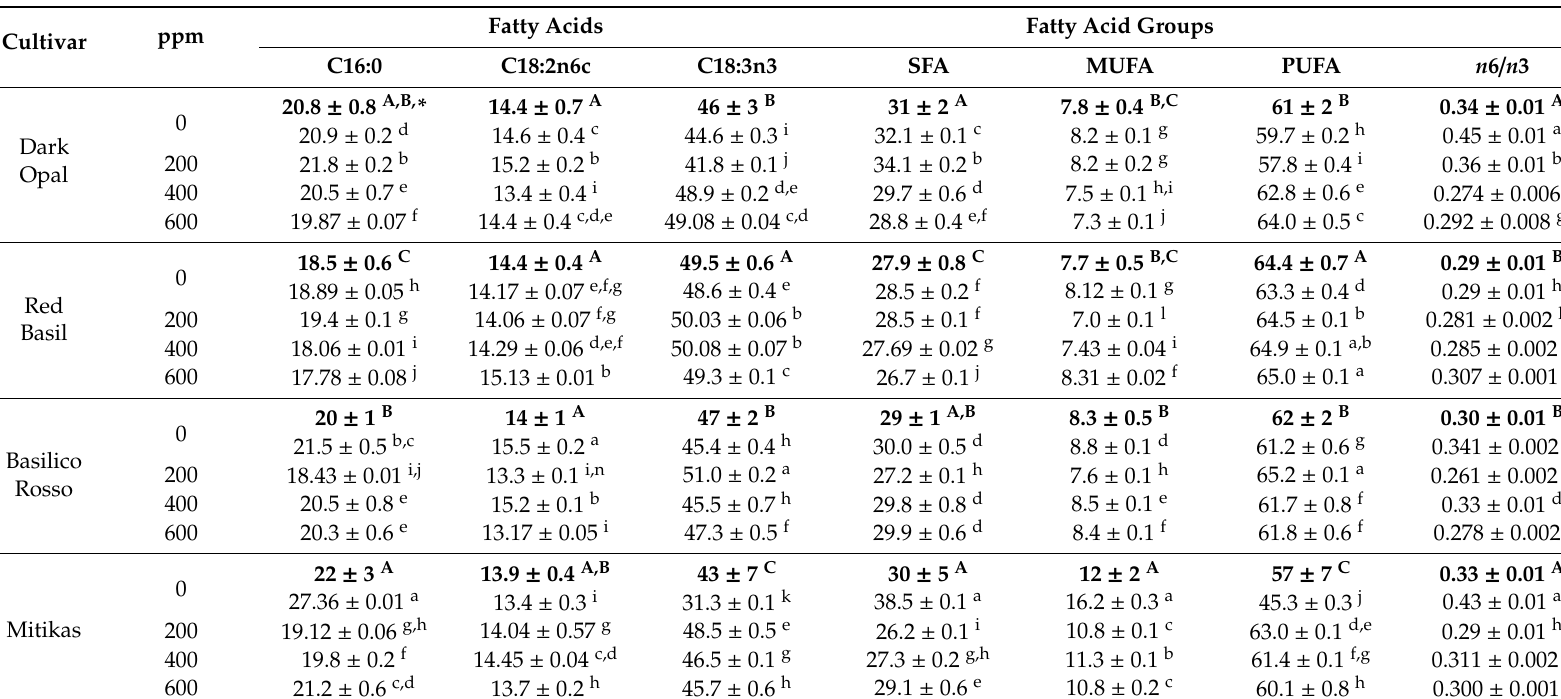
* Di ff erent capital letters (A–C) within each column represent significant di ff erences between the means of the four types of cultivars. Di ff erent small letters (a–l, n) within each column represent significant di ff erences between the means of each level of nitrogen input and cultivar. In both cases, the Tukey’s HSD test was used at p =